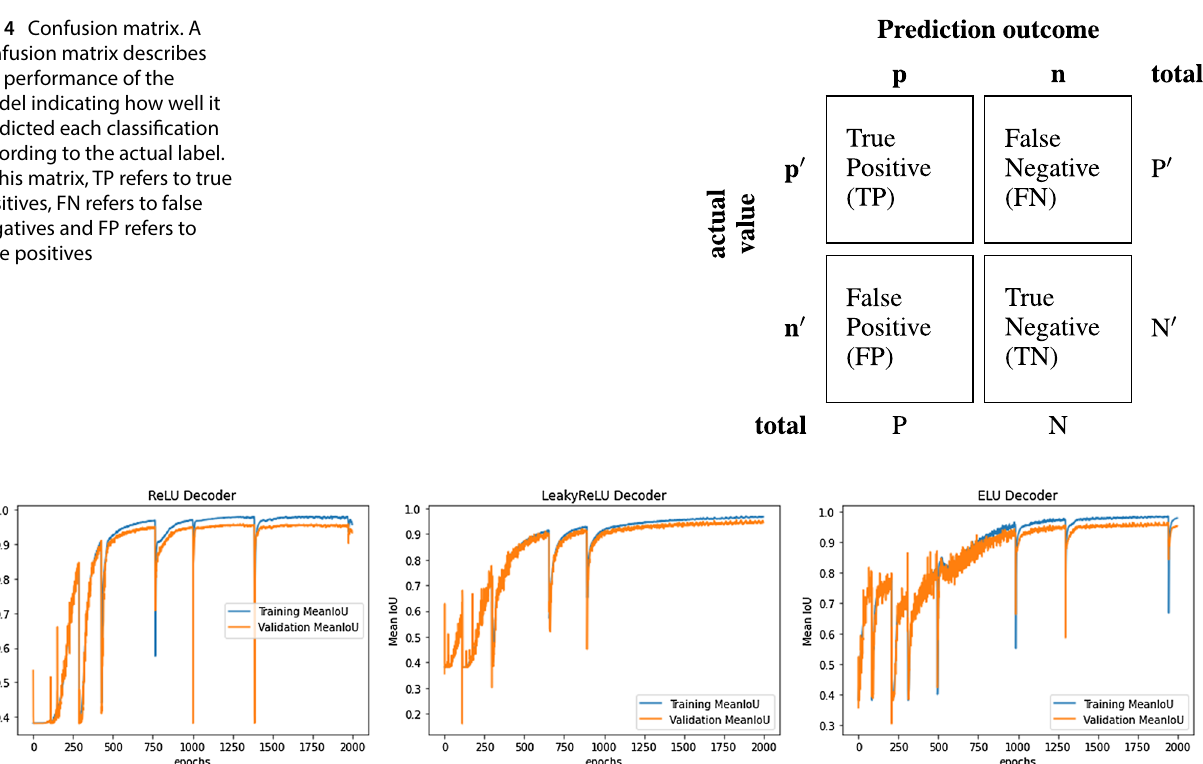
Fig. 4 Confusion matrix. A confusion matrix describes the performance of the model indicating how well it predicted each classification according to the actual label.